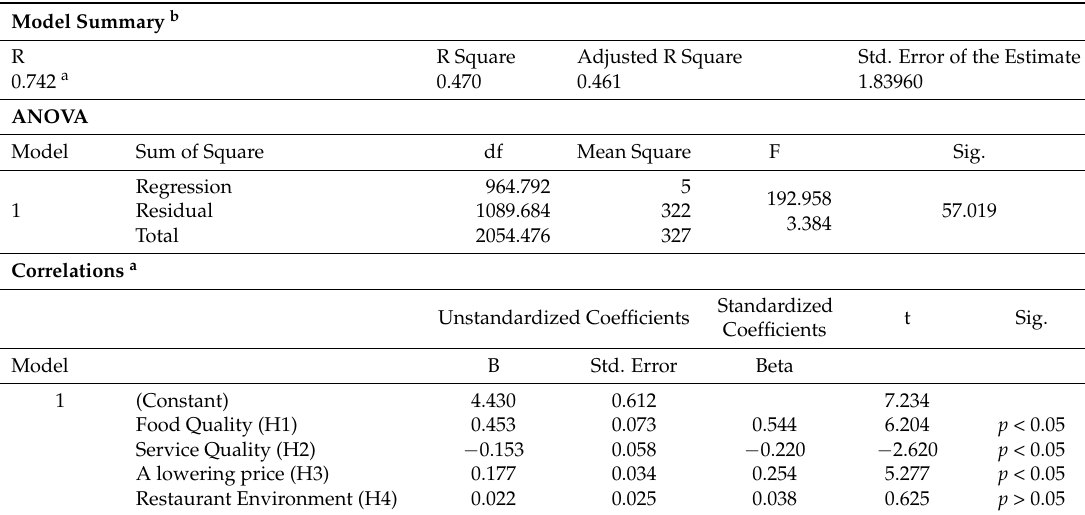
Table 4. Regression